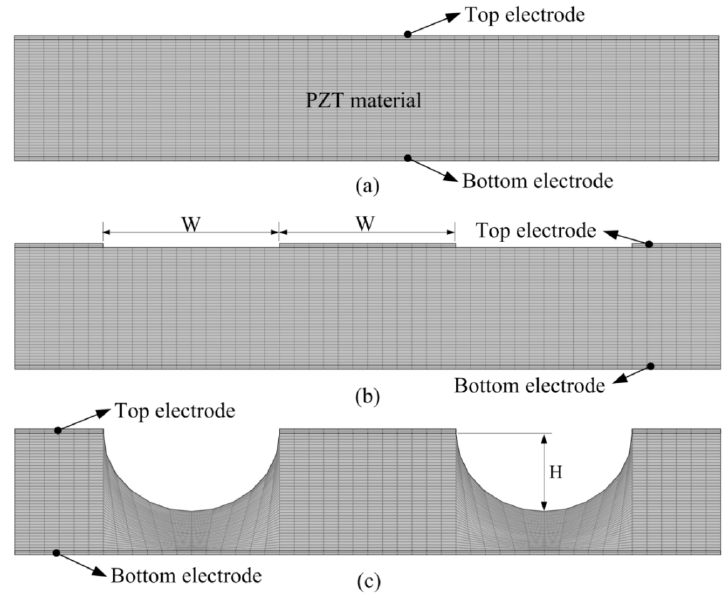
Figure 3. Finite element model for the PZT pyroelectric cells: ( a ) fully covered electrode,